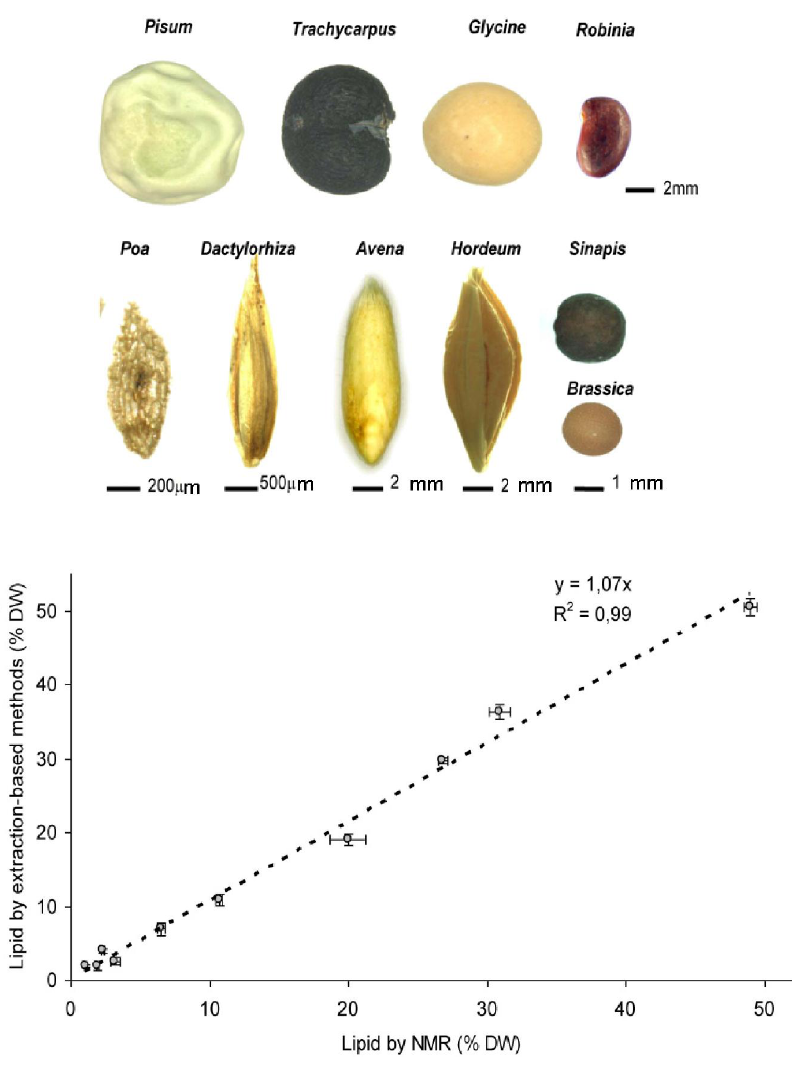
Figure 1. Measurement of seed lipid content using the MQ60 device. ( a ) Correlation of NMR data and conventional assays; ( b ) Seed/grain investigated by NMR were from Pisum sativum, Trachycarpus fortunei, Glycine max, Robinia pseudoacacia, Brassica napus, Poa pratensis, Dactylorhiza fuchsii, Sinapis alba, Sinapis alba, Avena sativa, Hordeum vulgare